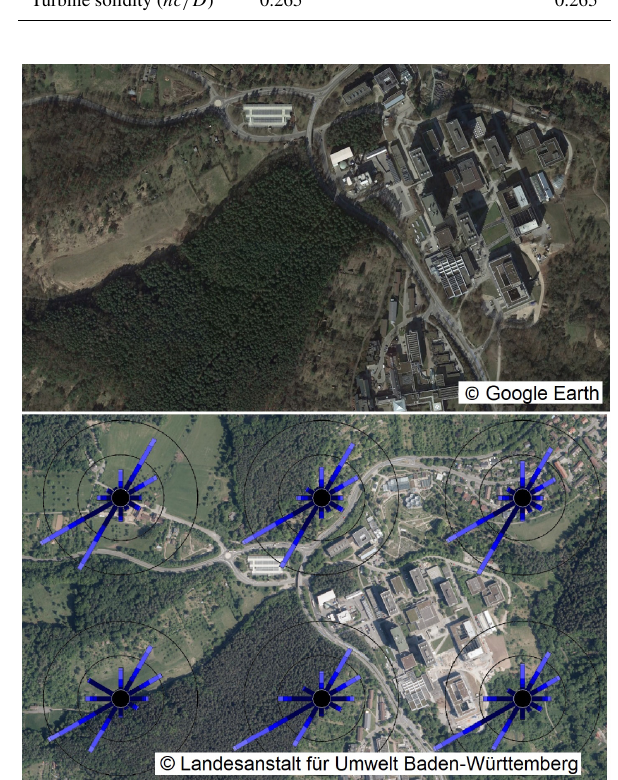
Figure 1. Aerial view of Morgenstelle campus (© Google Earth 2020) and wind rose from synthetic wind statistics (©Landesanstalt für Umwelt Baden-Württemberg